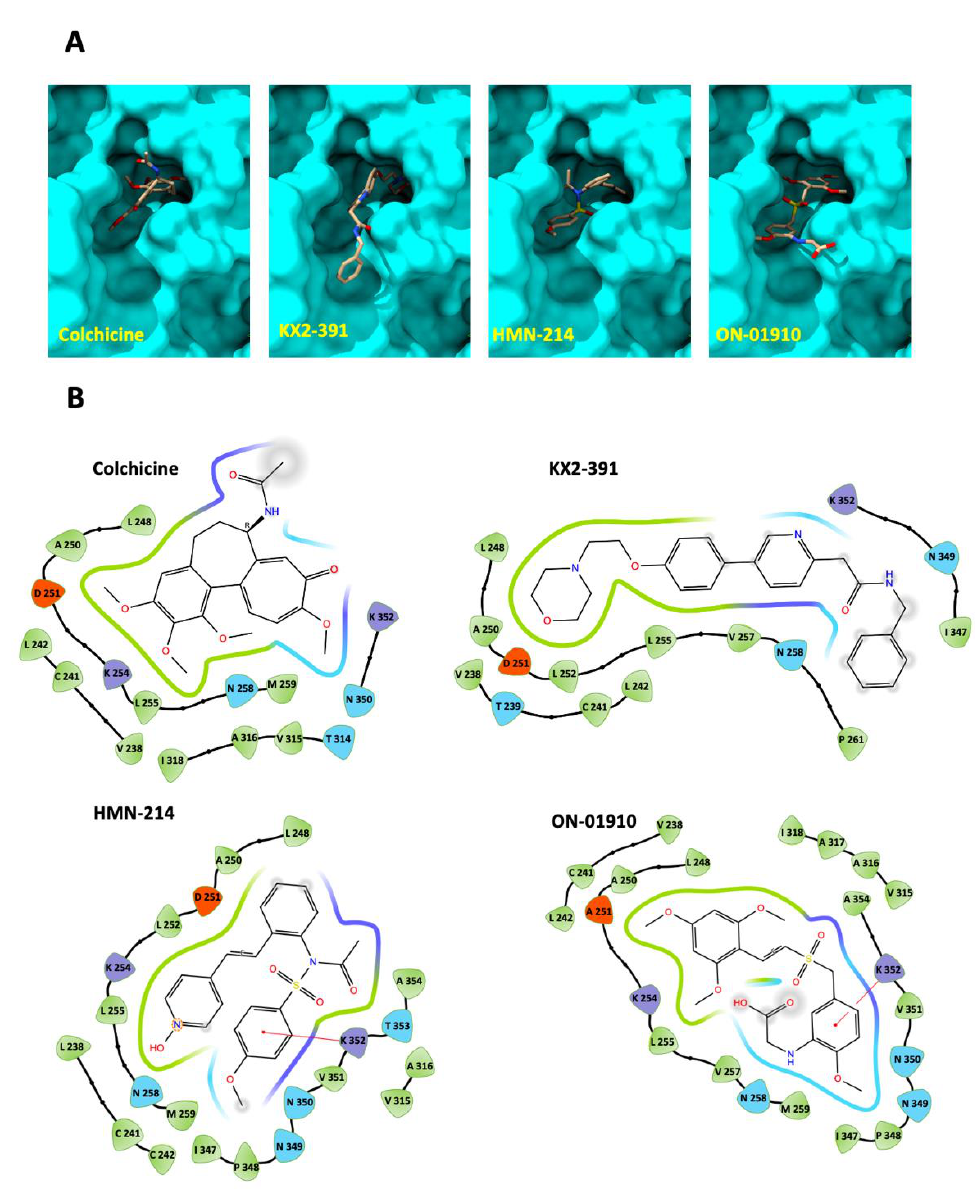
Figure 6. Docket pose against the β -tubulin colchicine binding site of kinase inhibitors that inhibit tubulin polymerization. ( A ) Docket pose of KX2-391, HMN-214, and ON-01910 against the colchicine binding site in β -tubulin and generated with AEDocking. ( B ) Maestro software was used to visualize the amino acids surrounding the β -tubulin binding site of colchicine, KX2-391, HMN-214, and ON-01910.